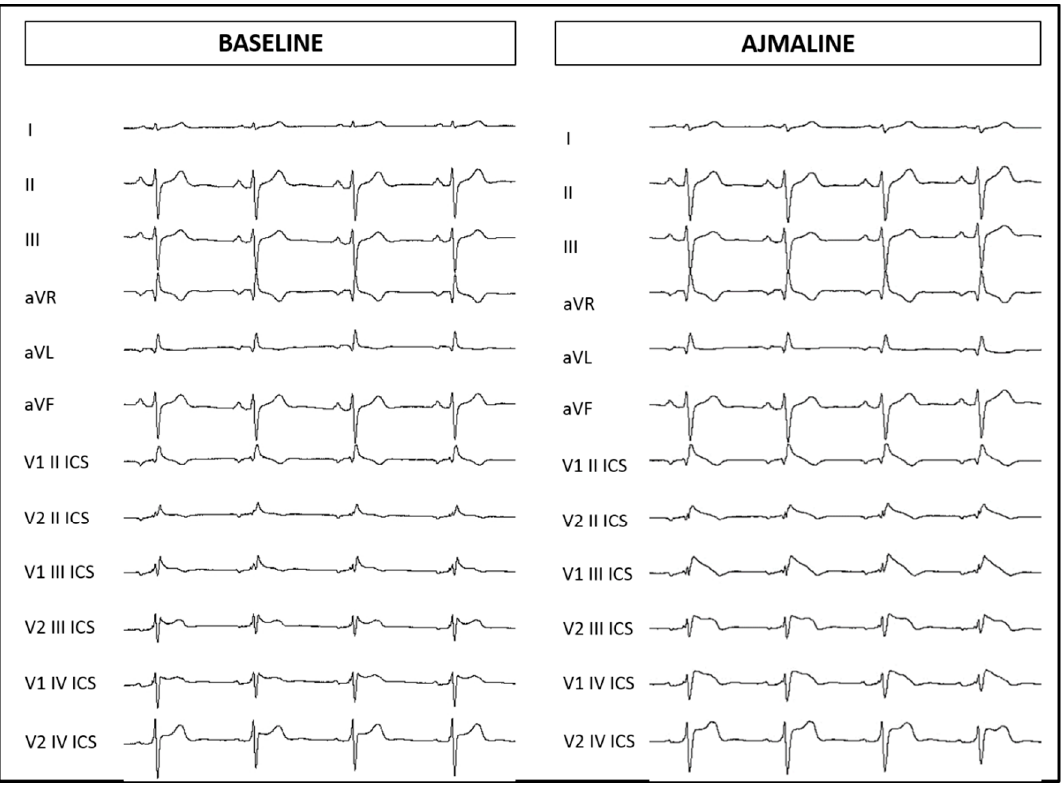
Figure 4. Electrocardiogram at baseline and after ajmaline administration for proband’s maternal aunt.